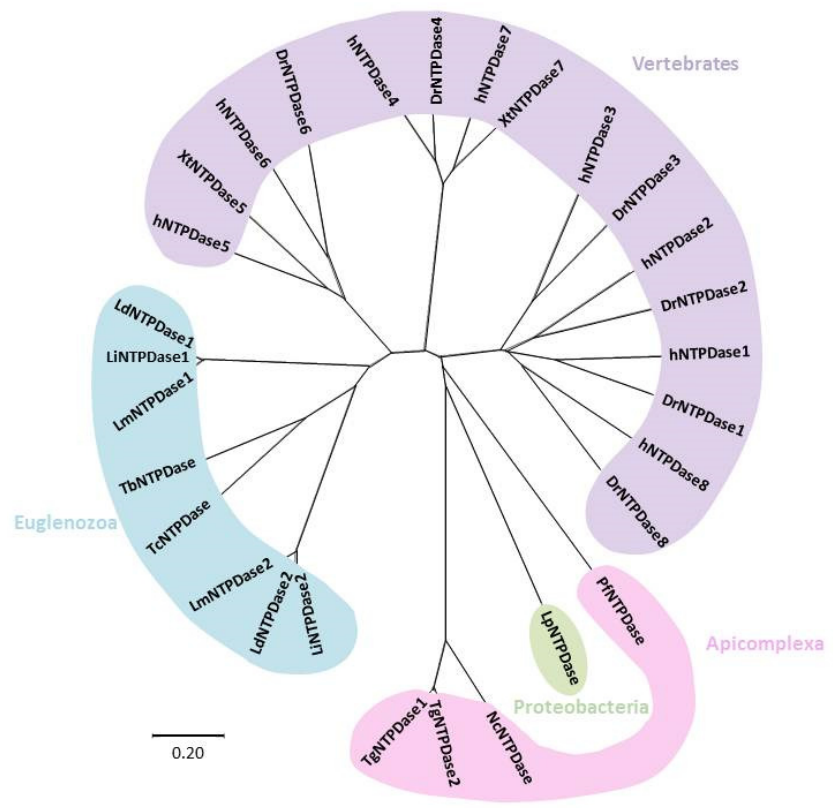
Figure 2. Radial phylogenetic tree from amino acid sequences of NTPDases. NTPDases from protozoan species are shown, together with NTPDases from other vertebrate species and a bacterium. The tree was generated using the ClustalW sequence alignment tool, with the resulting tree being built with the MEGA-X software, using the Neighbor-Joining method. Visualization was done with the program Figtree. The tree was drawn to scale, with branch lengths in the same units as those of the evolutionary distances used to infer the phylogenetic tree. The evolutionary distances were computed using the Poisson correction method and are in the units of the number of amino acid substitutions per site. NTPDases and their accession numbers are listed as follows. Human